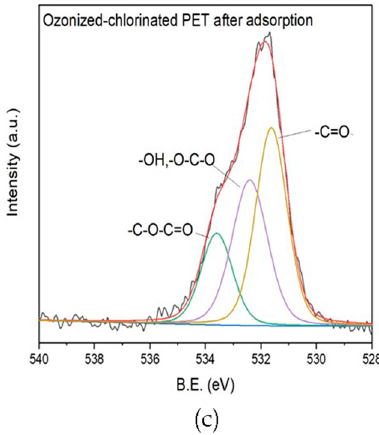
Figure 12. The result of XPS of ( a ) pristine PET, ( b ) ozonized PET and ( c ) ozonized-chlorinated PET